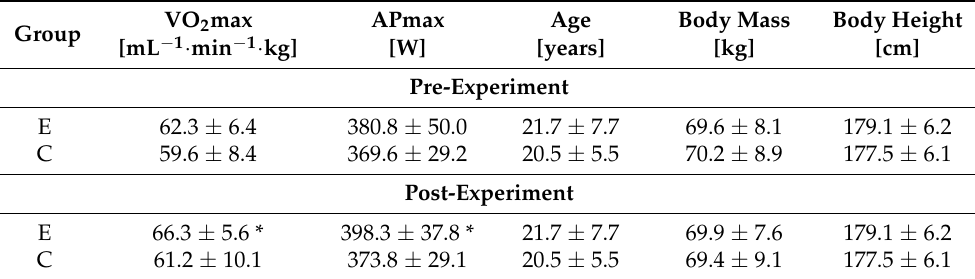
Table 1. Characteristics of the cyclist groups